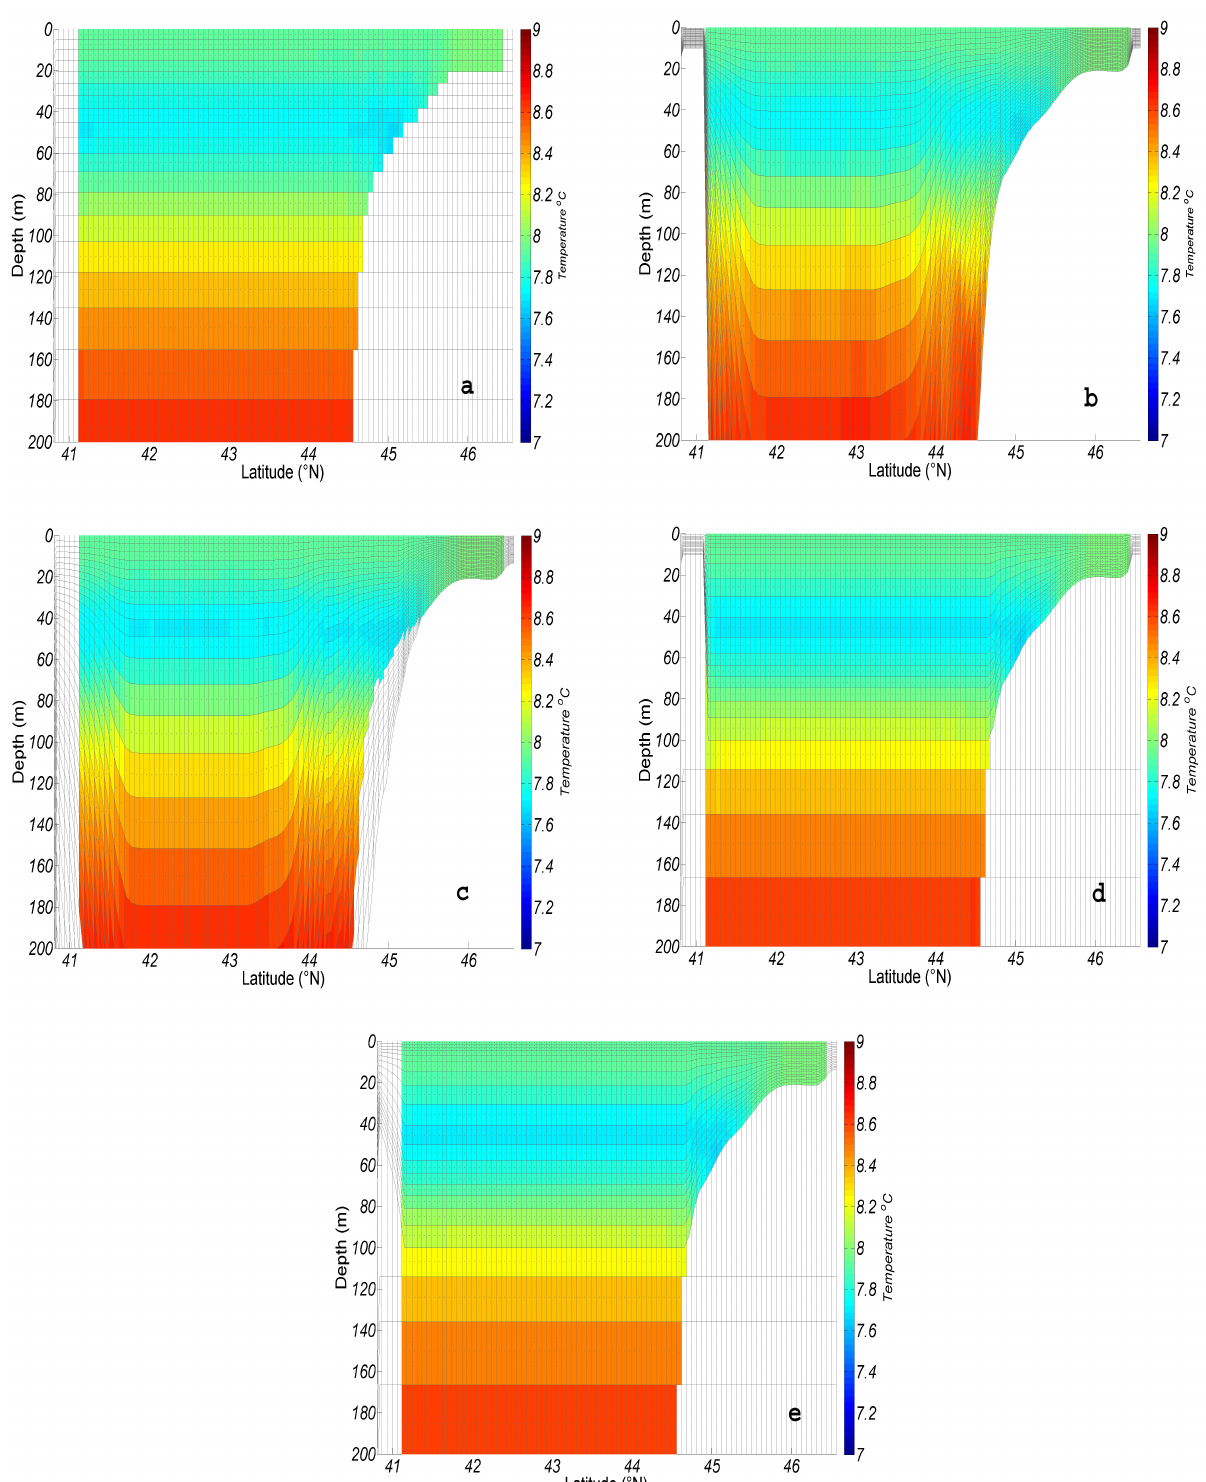
Fig. 5. Temperature distribution along 31 ◦ E after 3.5months of simulation: (a) ZCO; (b) SCO; (c) Z*SIG; (d) SZH; (e)